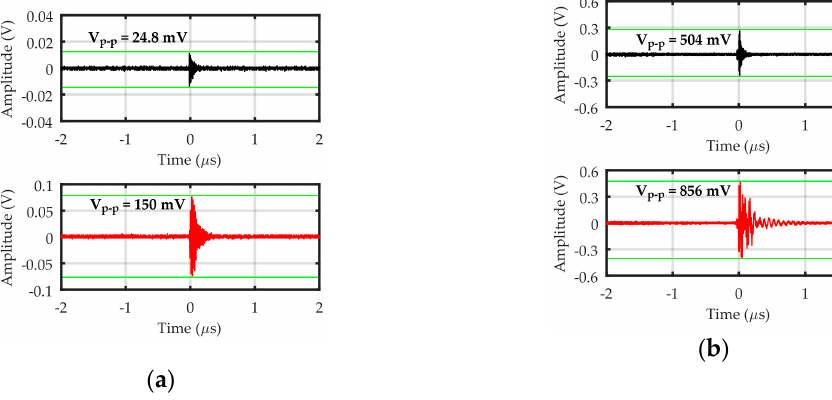
Figure 10. Schematic diagram of the measurement setup in which PD detection sensitivity of the prototype UHF antenna was tested: U = high-voltage supply, Z = short-circuit current limiting resistor, OSC = four-channel oscilloscope, TT = oil-filled transformer tank, PD = electrode system for surface partial discharge generation, PA = prototype meandered PIFA, CA = commercial UHF disk antenna as reference, C K = coupling capacitor, CD = coupling device (measuring impedance), CC = connecting cable, M = conventional partial discharge detector, PC = computer.